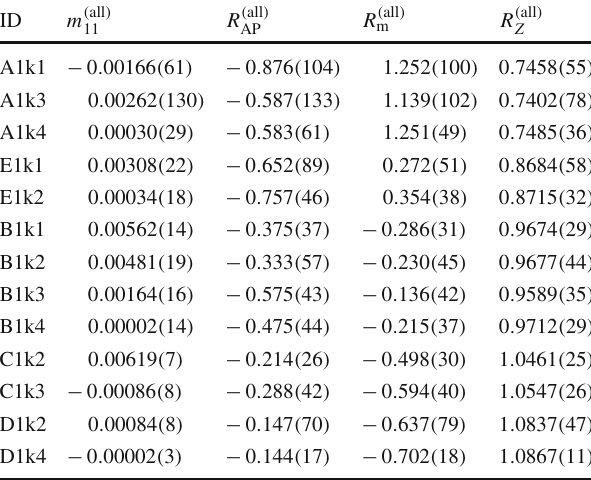
Table 6 Sea quark PCAC masses and estimators R AP , R m and R Z for LCP-0 (i.e., at the unitary point) for all topological sectors